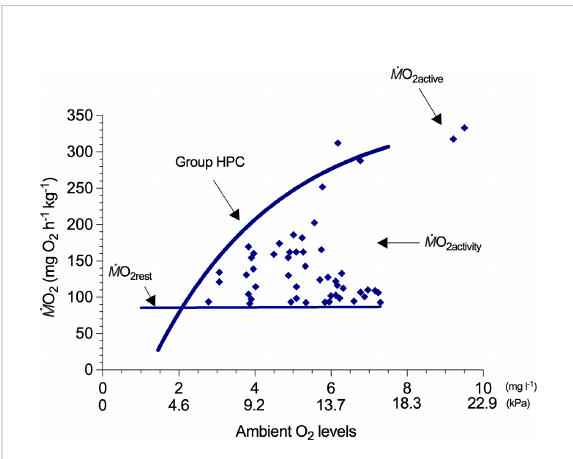
FIGURE 2 A hypoxia performance curve (HPC) for a group of fi sh which ) of whole- models a constraint on the oxygen uptake ( M O ˙ 2 _ MO 2 ) when the ambient oxygen (O 2 ) organism activities ( M O ˙ 2activity _ MO 2 activity level (oxygen concentration: mg L -1 ) is progressively reduced. In this example, a group of European sea bass ( Dicentrarchus labrax ) measured in the mass respirometry at 20°C (adapted values within from Claireaux and Lagardère, 1999), different M O ˙ 2 _ MO 2 the HPC are the results of spontaneous activity. The group- based HPC (group HPC) is mathematical modeling following an ). Group assumption that HPC encompasses all the ( M O ˙ 2activity _ MO 2 activity HPC is an estimate of the responses of a population of fi sh to in hypoxic water; hence, the model lacks a 95% CI. The M O ˙ 2 _ MO 2 ( M O ˙ 2activity ) when the full normoxia is referred to as active M O ˙ 2 _ MO 2 _ MO 2 active aerobic scope can accommodate the highest level of activities. Because multiple fi sh in the mass respirometry do not reach the standard metabolic rate at the same time and fi sh tend to interact when swimming in a school, the baseline is termed as resting M O ˙ 2 ( M O ˙ 2rest _ MO 2 ð _ MO 2 rest